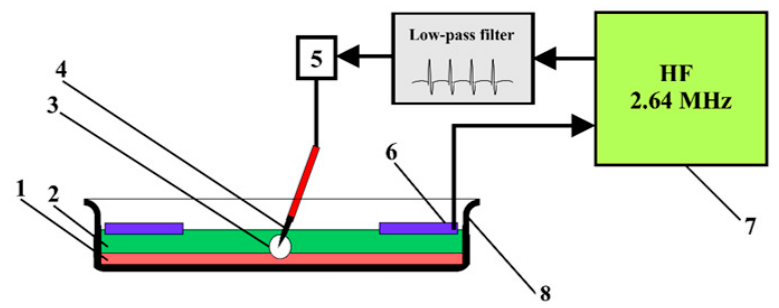
Figure 1. Schematic diagram of the experimental setup, showing (1) the stem cell culture, (2) layer of Ringer’s solution, (3) plasma discharge, (4) electrode applicator with a needle, (5) dispenser, (6) ring neutral electrode, (7) high-frequency generator and (8) Petri